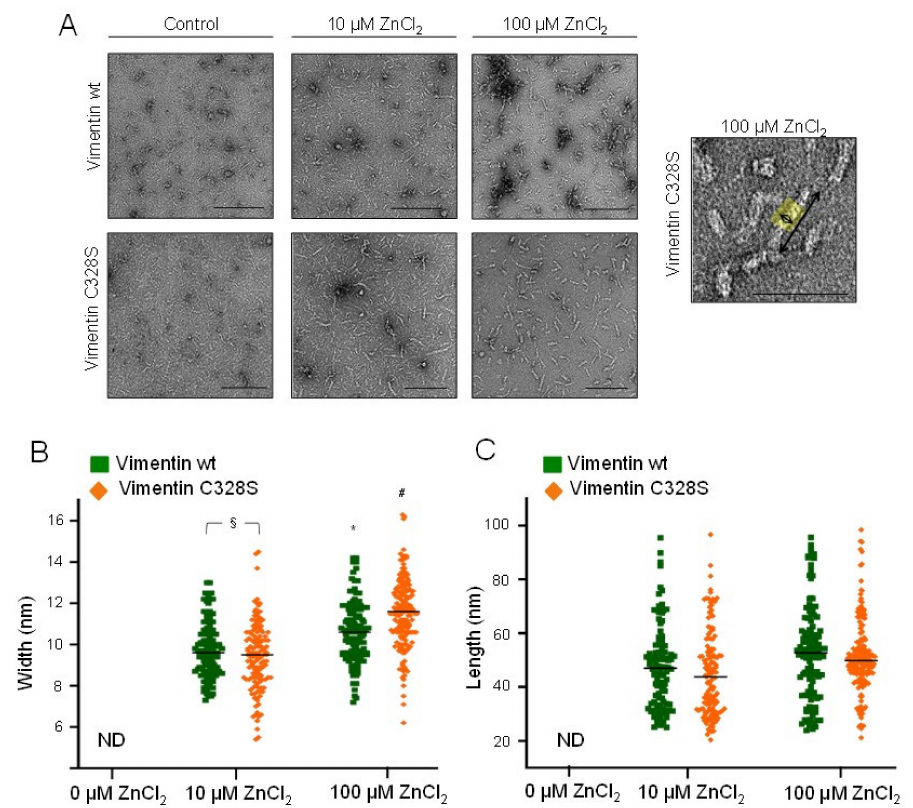
Figure 5. Observation of zinc-induced vimentin structures by electron microscopy. ( A ) Vimentin wt or C328S was incubated with the indicated concentrations of ZnCl 2 for 1 h at r.t., fixed, negatively stained, and inspected by EM. Scale bars, 200 nm and 100 nm for the right panel. The width and length of the observed fibrils were measured using FIJI software as illustrated in the right panel, and results are summarized in the graphs. ( B ) Width of the structures of at least 20 nm in length. ( C ) Length of the structures observed. Results shown are the mean values ± SEM of 50 “structures” per